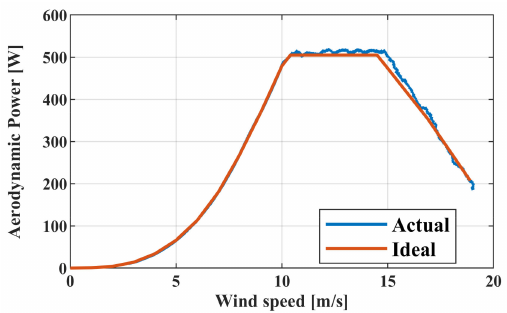
Figure 17. Actual and ideal aerodynamic power curves depending on wind speed.